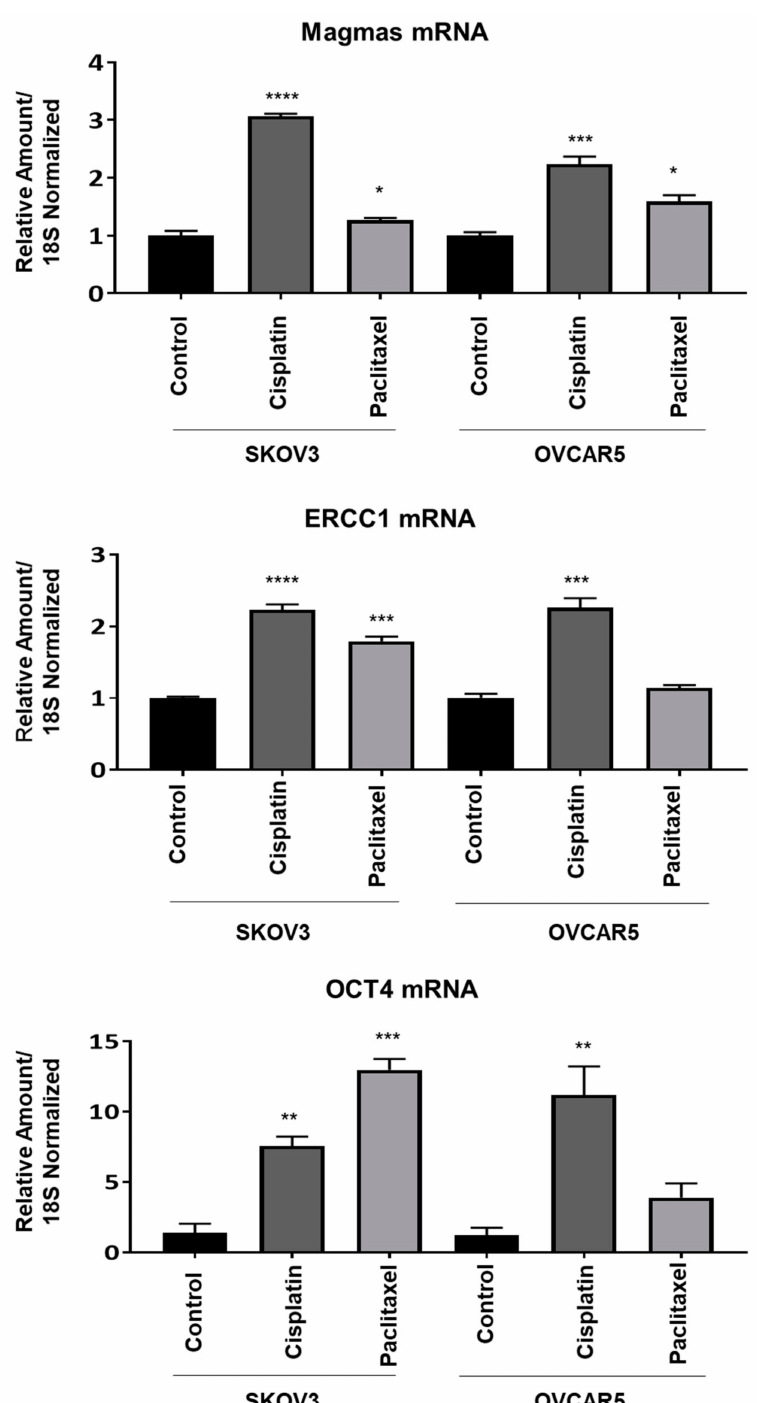
Figure 3. The mRNA expression of Magmas, ERCC1 and OCT4 in SKOV3 and OVCAR5 ovarian cancer cell lines. Magmas, ERCC1 and OCT4 mRNA expression in SKOV3 and OVCAR5 cells were performed after treatment with IC 50 doses of cisplatin or paclitaxel as described previously [83,123]. The relative expression of gene of interest was normalized to housekeeping 18S gene. Data are shown as the mean of + SEM (n = 3). Significance between the groups was deduced by One-way ANOVA and is indicated by * p > 0.05, ** p > 0.01, *** p < 0.001, **** p <